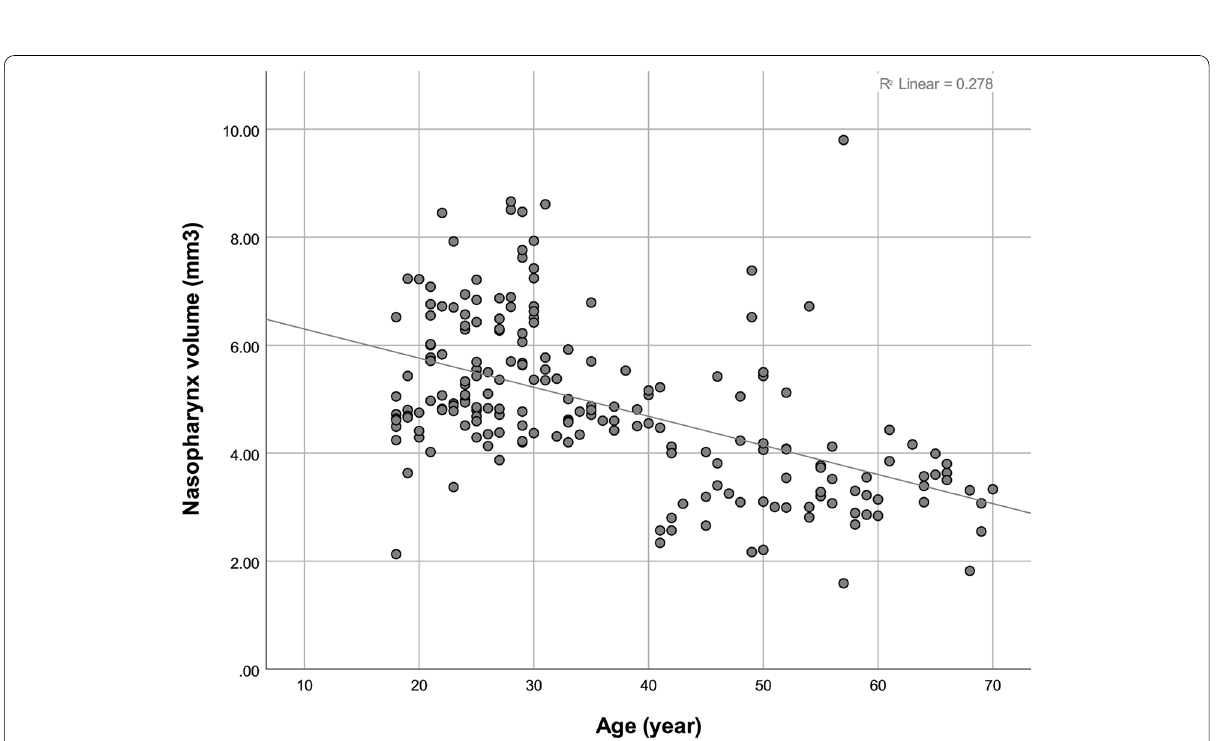
Fig. 6 A scatterplot showing the correlation between age (year) and the nasopharynx volume (mm 3